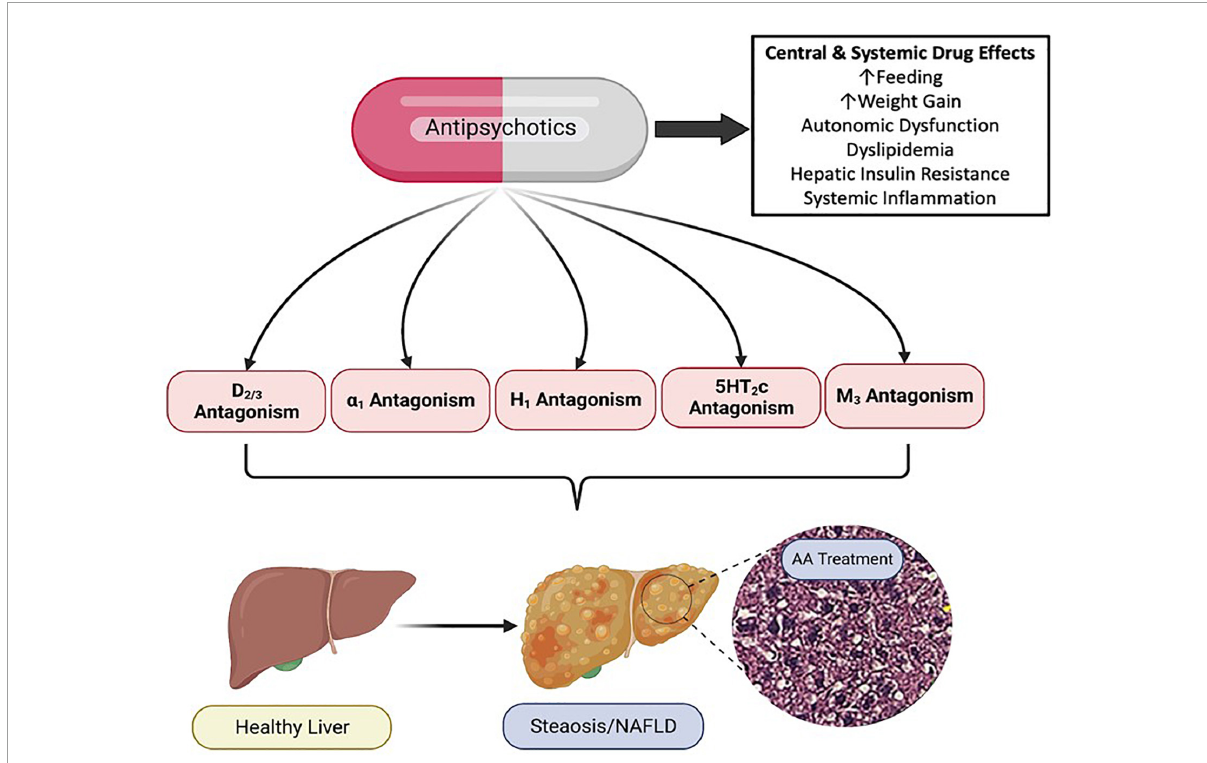
FIGURE3 Pharmacology of Antipsychotic Induced Non-alcoholic Fatty Liver Disease (NAFLD/NASH). Antipsychotic medications have complex and diverse receptor pharmacology across the drug class, displaying potent antagonism and inverse agonism of multiple G protein coupled receptors. Antipsychotic (AA) associated metabolic side effects, including those associated with NAFLD/NASH can be mediated centrally and peripherally, and likely involve multiple organ systems and cell types. NAFLD, non-alcoholic fatty liver disease; NASH, non-alcoholic steatohepatitis; D, dopamine receptor; α , alpha adrenergic receptor; H, histamine receptor; 5HT, serotonin receptor; M, muscarinic receptor. Figure created with